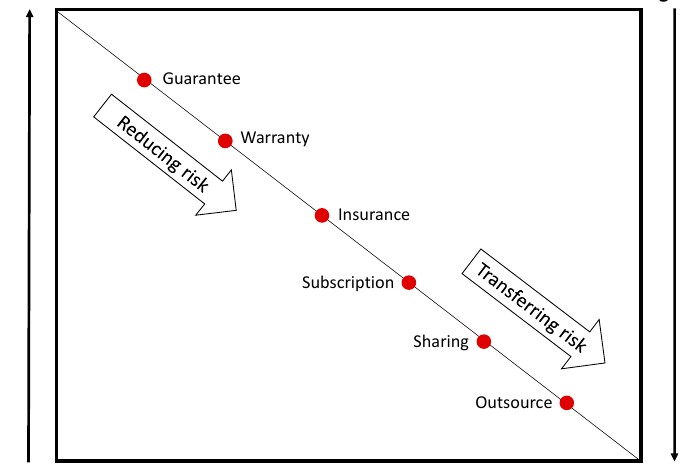
Figure 10. Options for risk barrier reduction.